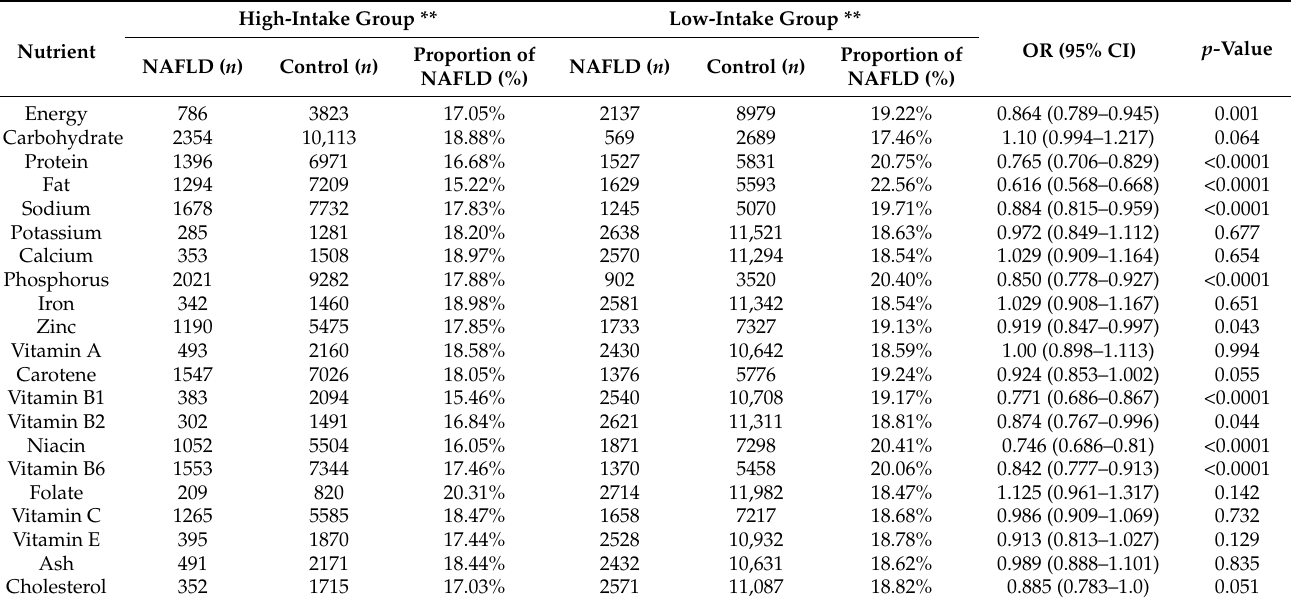
Table 3. Comparison of the non-alcoholic fatty liver disease (NAFLD) case proportions between several nutrients’ high-intake and low-intake groups among the * total participants ( n = 15,725), as determined by univariate analyses.